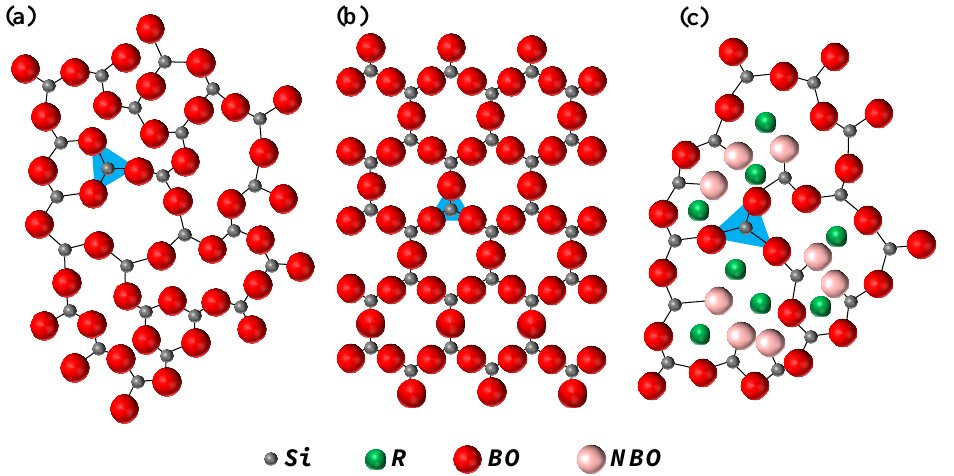
Figure 1. Two-dimensional representation of network structure of ( a ) vitreous and ( b ) crystalline silica; ( c ) vitreous silicate ( R stands for a generic network modifier cation, while BO and NBO stand for bridging oxygen and non-bridging oxygen, respectively).